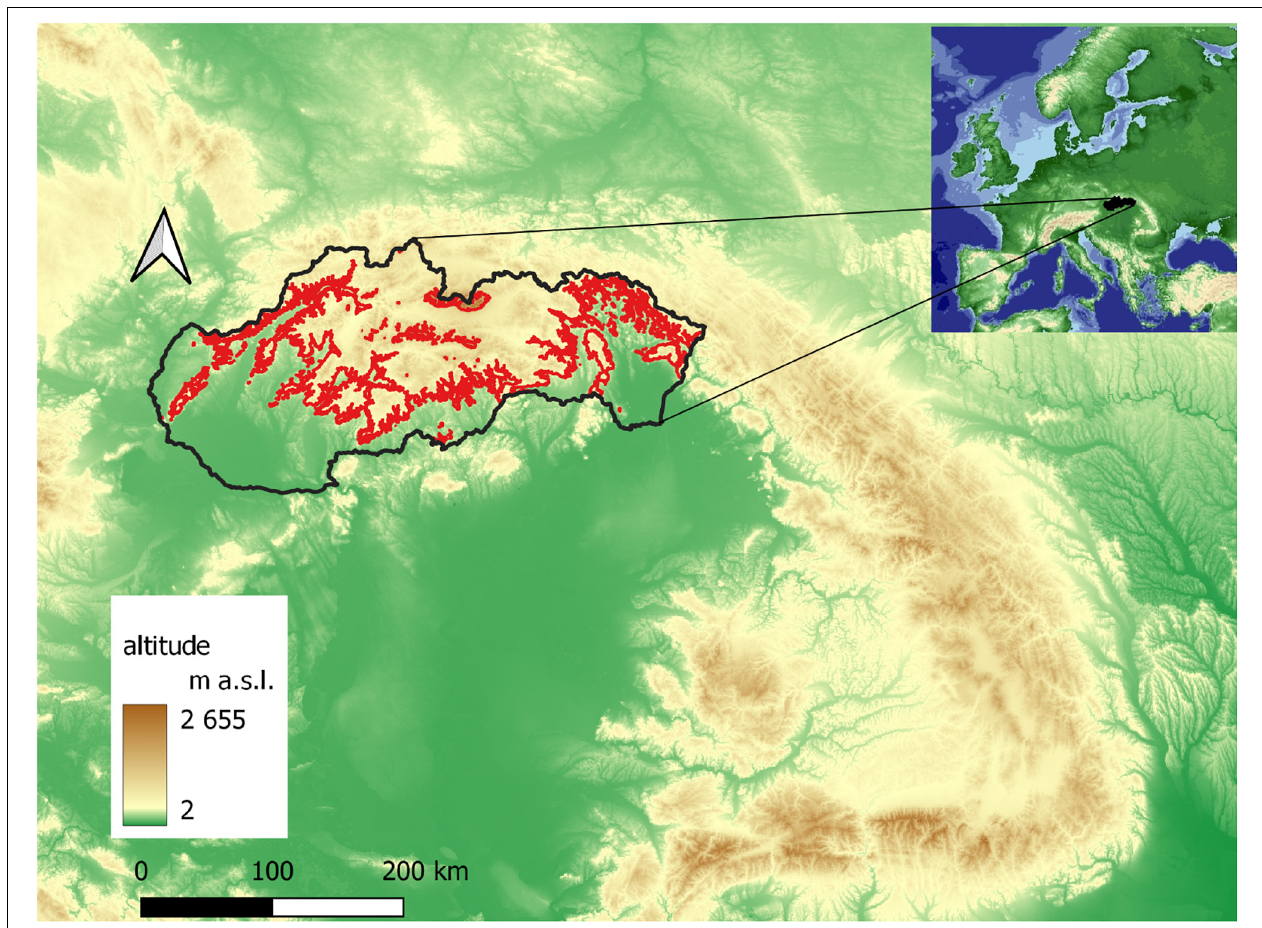
FIGURE 1 | Norway spruce distribution in Slovakia (red line: borders of 390–1,400 m a.s.l.